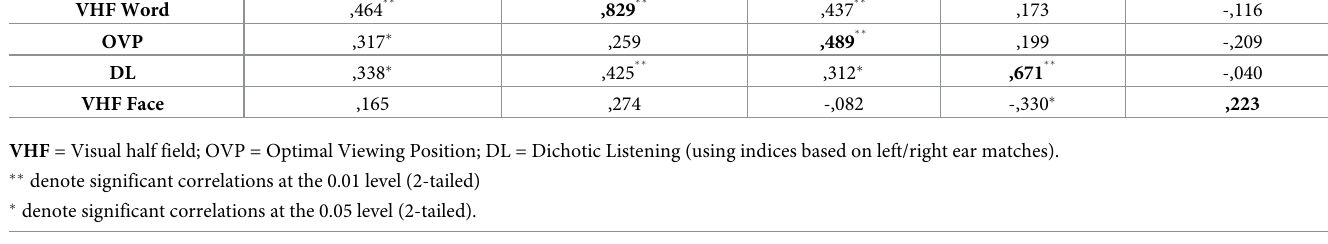
Table 5. Pearson correlations between the lateralization indices based on reaction times for session 1 (variables in rows) and session 2 (variables in columns, indi- cated by task name 2). The test-retest correlations per task are highlighted in bold.